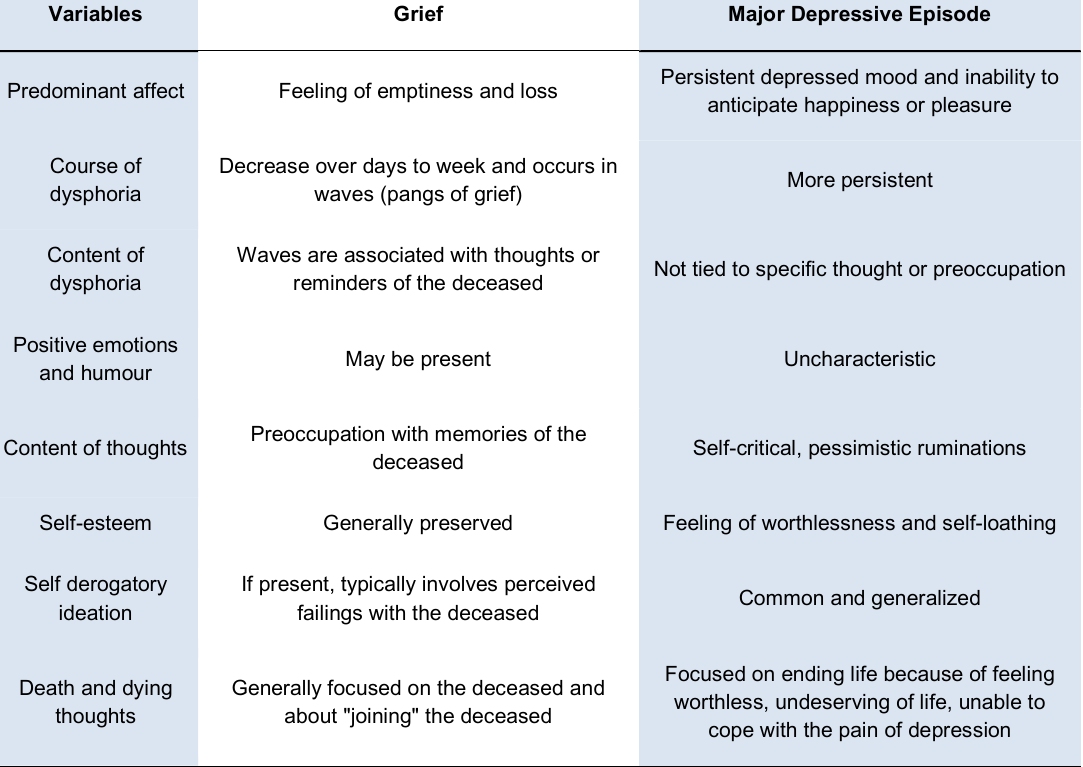
Table 1. DSM-5 variables proposed for differentiating Grief and Major Depressive Episode